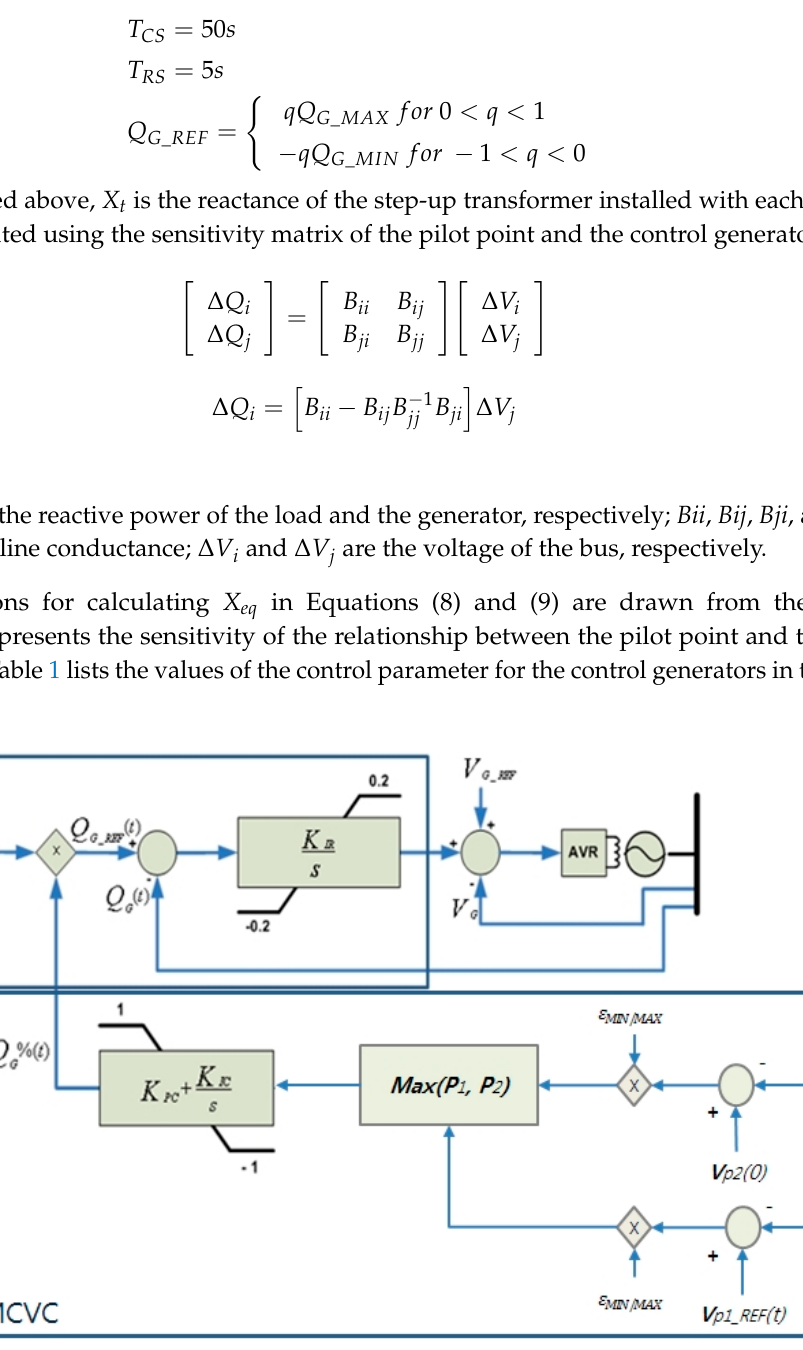
Figure 7. Control block for the multiple continuous voltage control (MCVC) and the reactive power dispatcher (RPD).